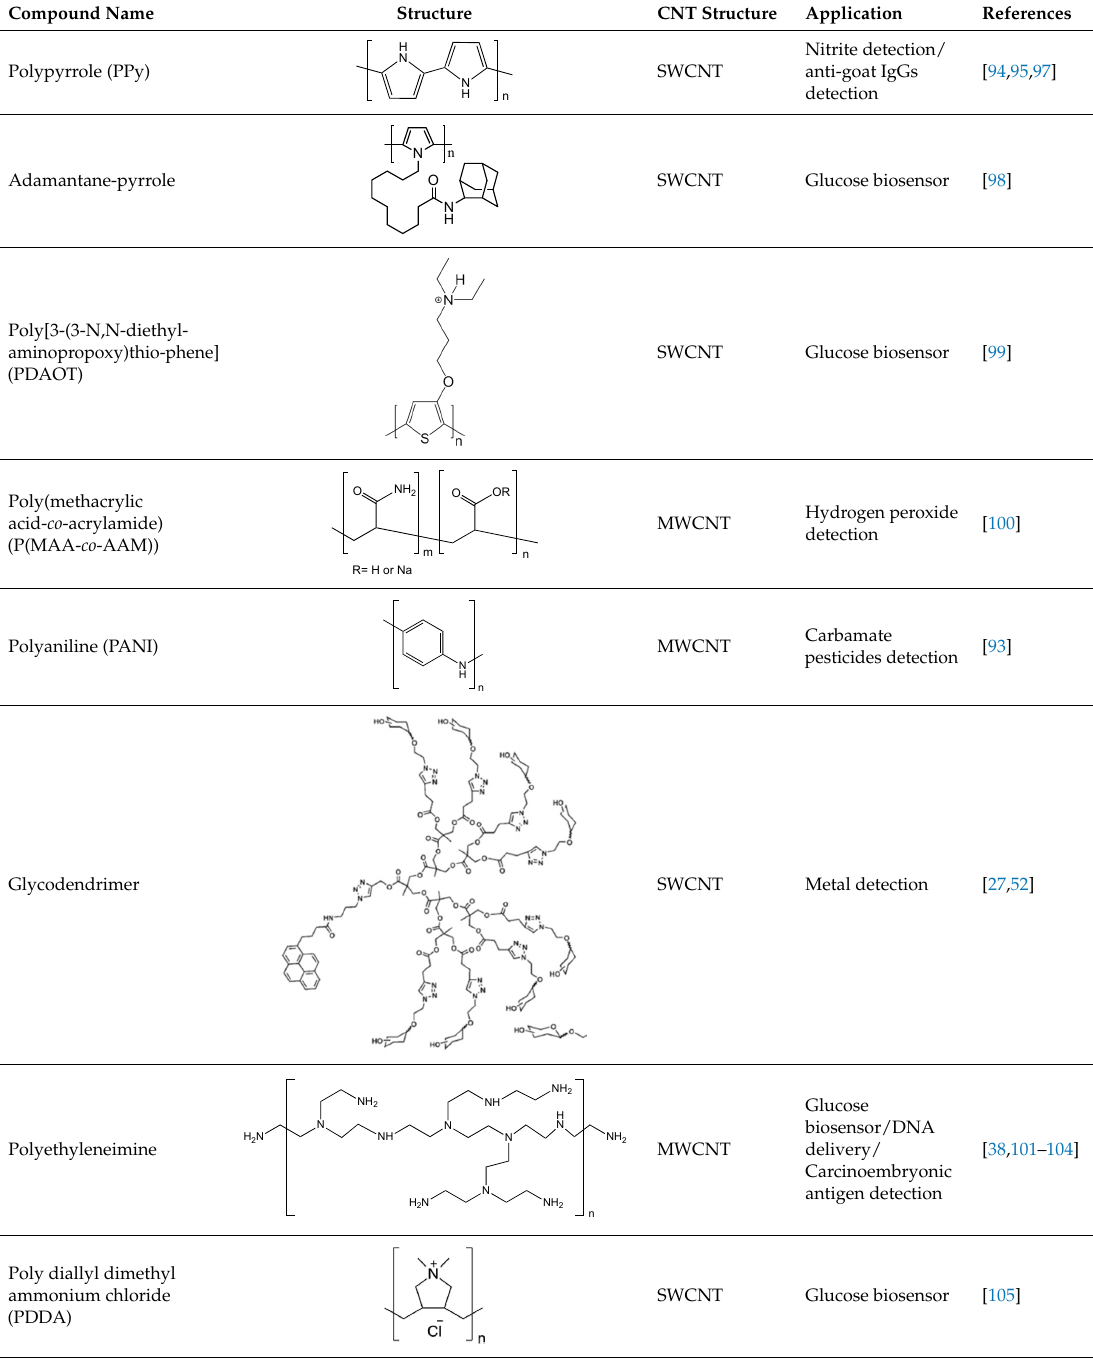
Table 2. List of aromatic compounds used for non-covalent functionalization of carbon